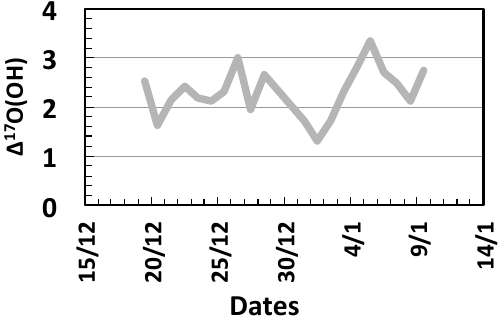
Figure 7. Same as Fig. 5 but for (cid:49) 17 O of OH.